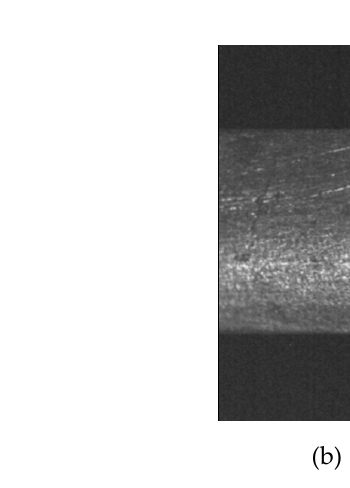
Figure 8. ( a ) Rectangular cylindrical surface to perform cylindrical surface modeling. ( b ) Micro laser line projected on the cylindrical surface to retrieve the surface topography.